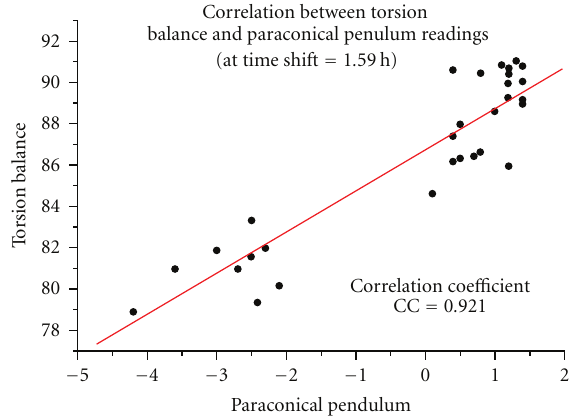
Figure 8: Correlation and the correlation coe ffi cient between these series of observations at a correlation spacing of 1.59 hours.